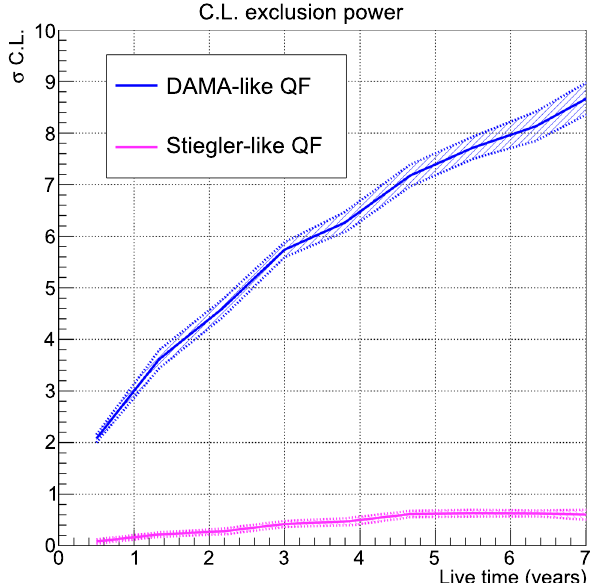
Fig. 11 Influence of a crystal dependent quenching factor for an extreme, illustrative DM model with m χ = 10 GeV/c 2 and σ p = 2 . 9 × 10 −